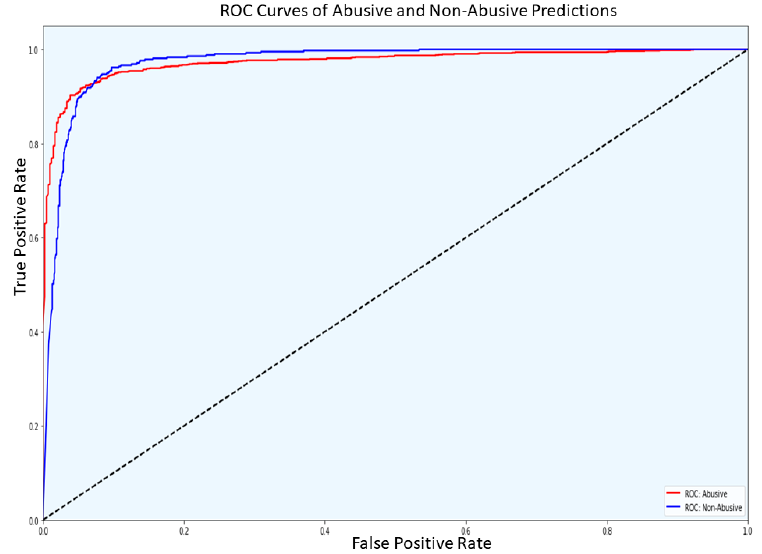
Figure 11. ROC Curves for Abusive and Non-Abusive predictions made by CASE.